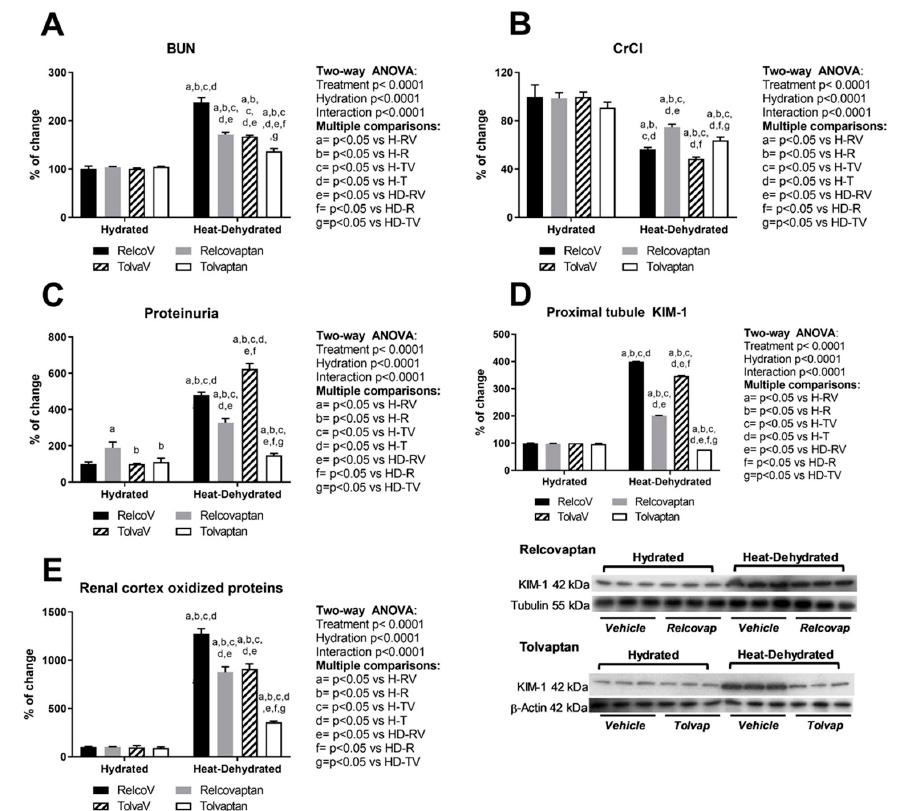
Figure 1. Relcovaptan and tolvaptan conferred nephroprotection in heat stress-dehydrated rats rehydrated with a 10% fructose beverage. ( A ) Blood urea nitrogen (BUN) was increased by heat stress and rehydration with a fructose beverage; relcovaptan and tolvaptan treatments prevented this e ff ect. ( B ) Creatinine clearance (CrCl) was significantly decreased by heat stress and rehydration with a fructose-containing beverage; relcovaptan and tolvaptan treatments partially prevented this e ff ect. ( C ) Proteinuria, ( D ) proximal tubule KIM-1 expression, and ( E ) oxidative stress were increased by heat stress and fructose beverage rehydration. Relcovaptan and tolvaptan treatments prevented such e ff ects, with tolvaptan being more e ff ective. For western blotting, three random samples per group were selected. Proteins of interest and the respective loading controls were run independently at the same time using the same conditions. The raw dataset is available in the Supplementary Table 1. Twenty-four-hour fluid intake, rehydration fluid intake, and body weight loss after heat stress.